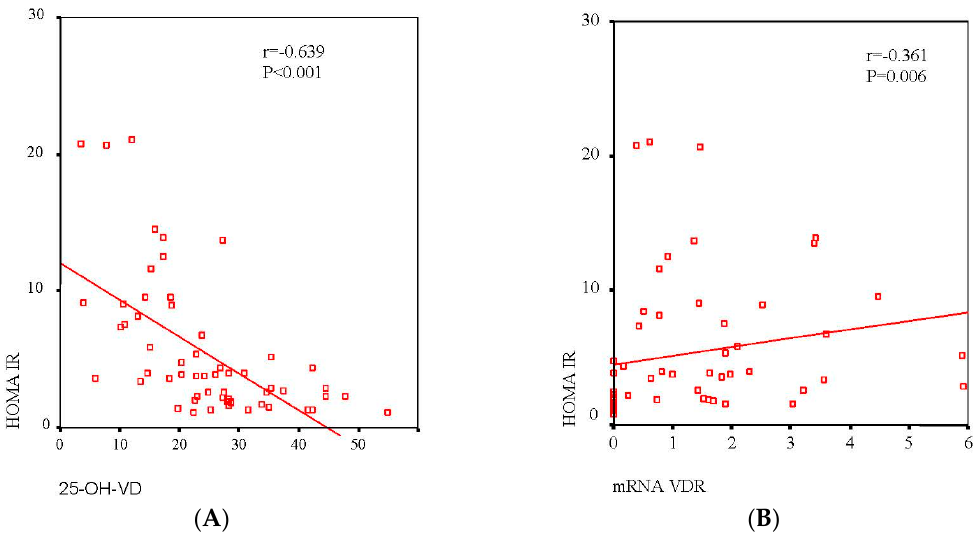
Figure 1. Association between serum levels of VD ( A ) and VDR mRNA expression in VAT ( B ) with HOMA-IR. A linear relationship was determined by Pearson’s correlation coefficient test; 95% confidence interval. Table 3. Multiple regression analysis where the dependent variable is the level of HOMA-IR and independent variables are sex, age, BMI, waist, 25-OH-VD, and mRNA VDR expression in VAT. Variable B